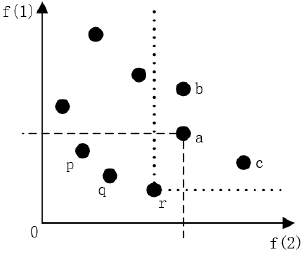
Figure 2. Schematic diagram of fast non-dominated sorting.